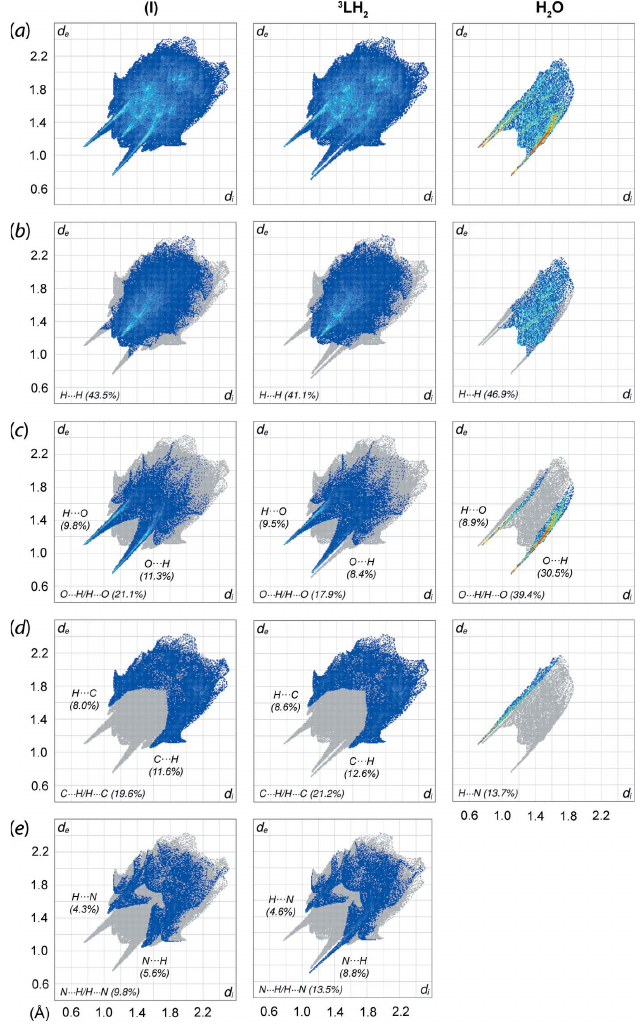
Figure 5 ( a ) The overall two-dimensional fingerprint plots for (I) and for the individual 3 L H 2 and water molecules, and those delineated into ( b ) H (cid:2)(cid:2)(cid:2) H, ( c ) H (cid:2)(cid:2)(cid:2) O/O (cid:2)(cid:2)(cid:2) H, ( d ) H (cid:2)(cid:2)(cid:2) C/C (cid:2)(cid:2)(cid:2) H and ( e ) H (cid:2)(cid:2)(cid:2) N/N (cid:2)(cid:2)(cid:2) H contacts. The percentage contributions to the surfaces are indicated therein.